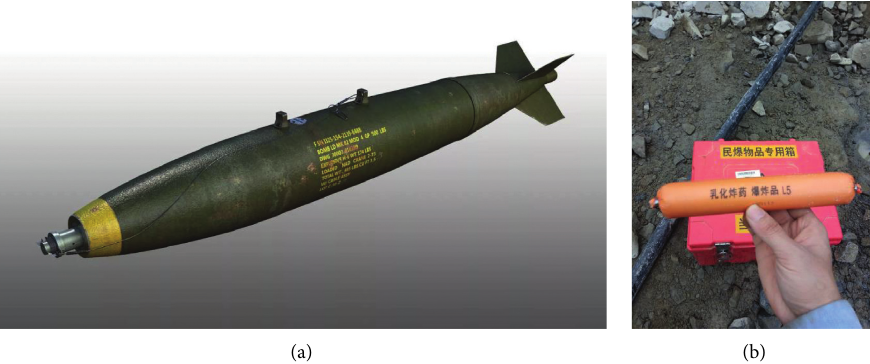
Figure 1: Shapes of the military charges and rock emulsion explosive in construction site. (a) Aerial bomb. (b) Rock emulsion